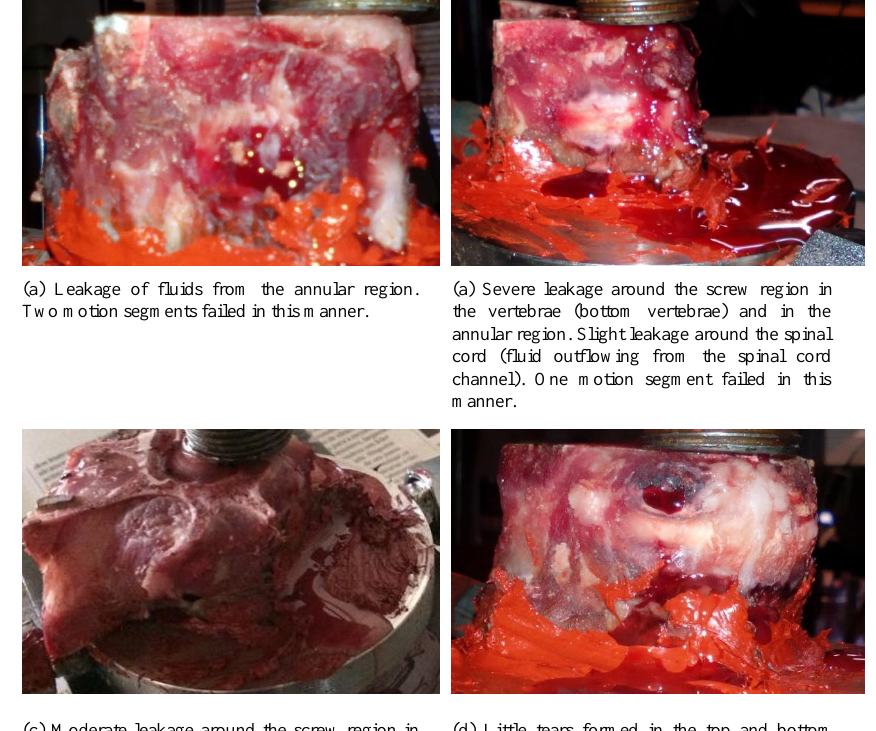
Figure 6. Representative images of different configurations of failure in MSs, during the inflation procedure.